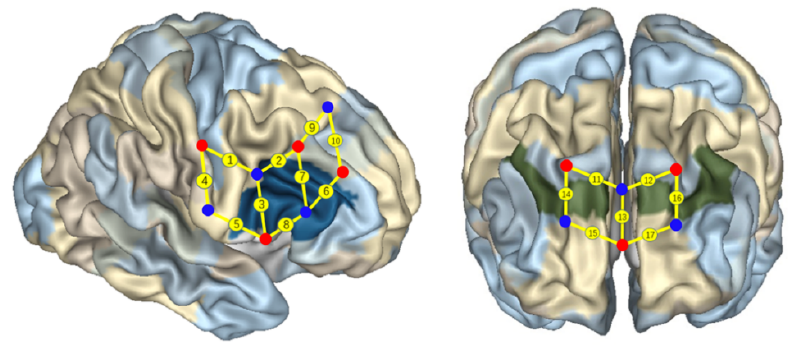
Figure 3. Localization of regions of interest.